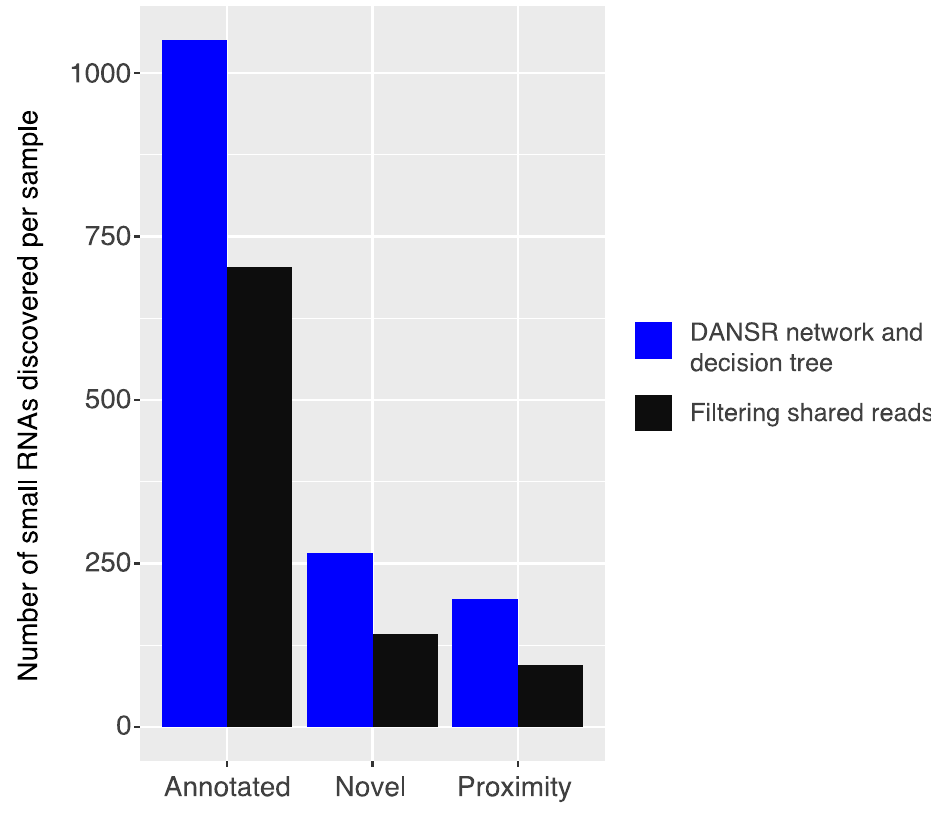
Figure 4. Comparison of approaches to multi-mapped reads. Average number of small RNA clusters discovered per sample in the deep-sequenced colorectal cancer cohort when using DANSR’s combined network model and decision tree approach to deducing the correct alignment for multi- mapped reads versus filtering shared reads. Clusters are grouped by annotation type: annotated small RNAs, novel clusters that are unannotated, and clusters in close proximity to a known annotation. DANSR’s approach results in significant numbers of small RNAs spanning homologous genomic regions remaining discoverable compared to the filtering approach.